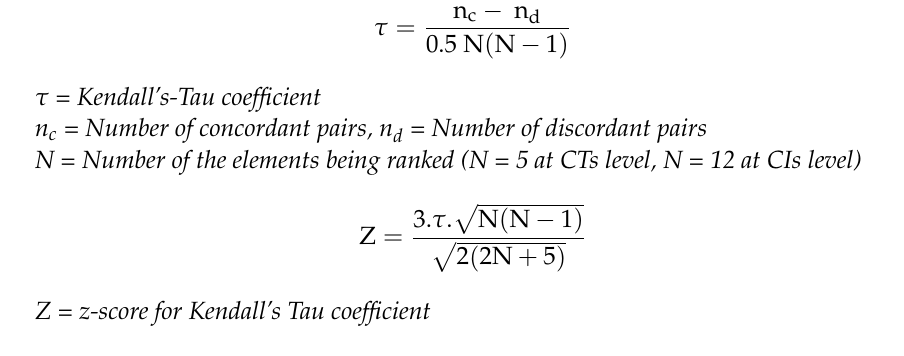
Table 5. Kendall’s-tau agreement degree